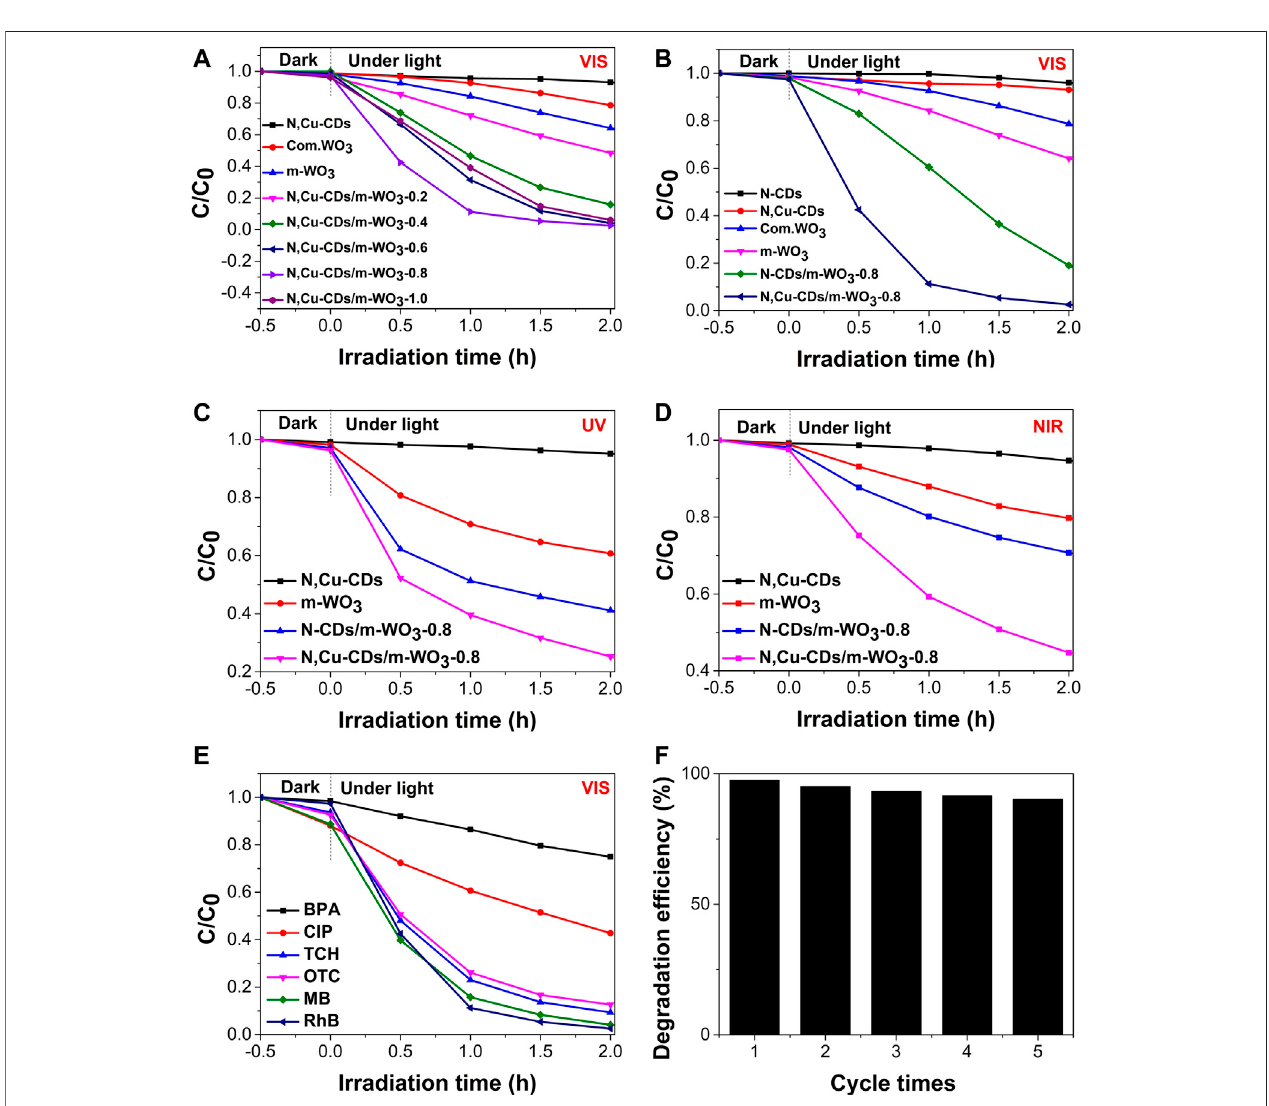
FIGURE7| Photocatalyticperformanceofas-synthesizedsamplesunderUV,vis,andNIR lightirradiation. (A) Thephotocatalyticef fi cienciesofm-WO 3 decorated with different amount of N,Cu-CDs under visible light irradiation; (B – D) were the comparasion of photocatalytic activities under UV, vis, and NIR light irradiation, respectively; (E) The photocatalytic ef fi ciencies on various pollutants over N,Cu-CDs/m-WO 3 -0.8 under visible light irradiation; (E) The photocatalytic stability of